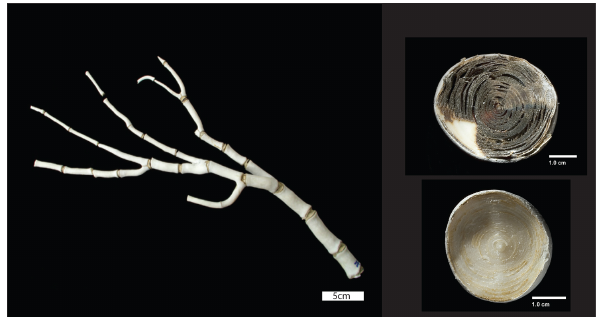
Figure 2. Bathymetric map of study area with coral sampling loca- tions noted. Map generated using